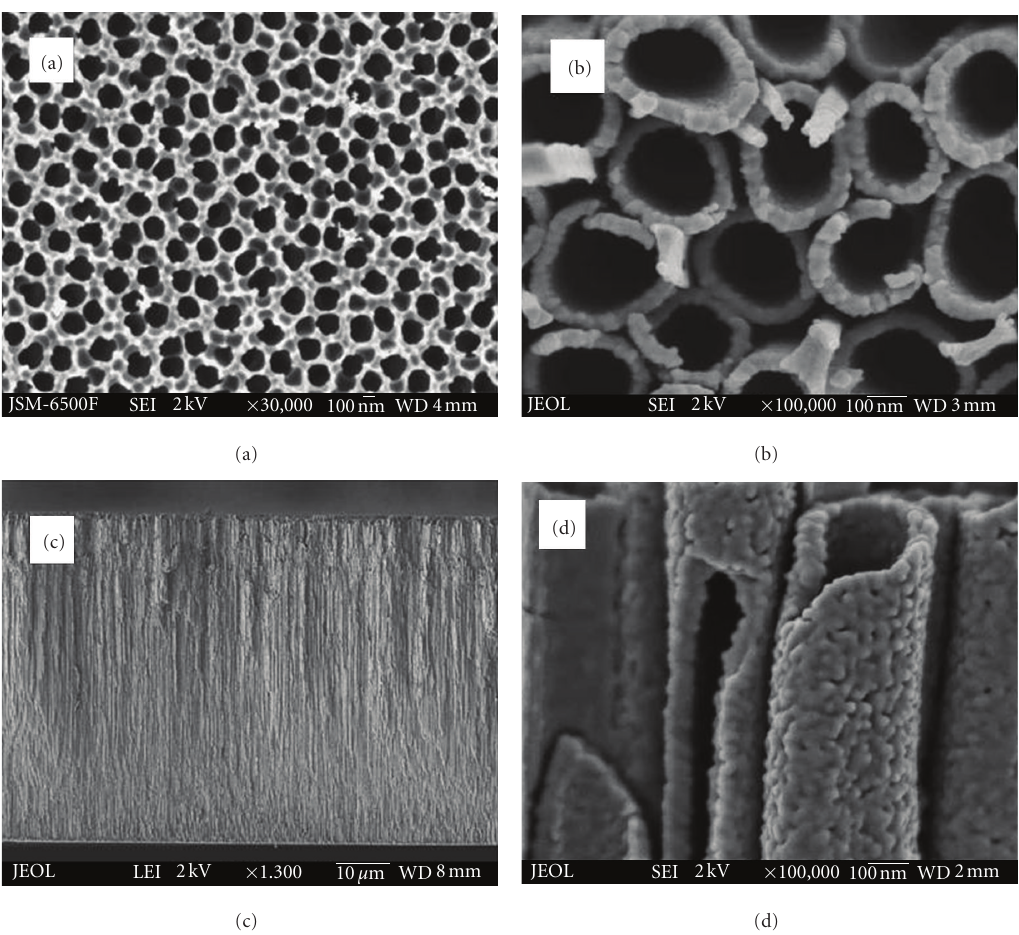
Figure 1: FE-SEM photographs of the titania nanohole arrays: (a) surface morphology of anodic alumina as starting material, (b) surface morphology of titania nanohole array, (c) cross-section of titania nanohole array, and (d) cross-section detailing (c) [48].